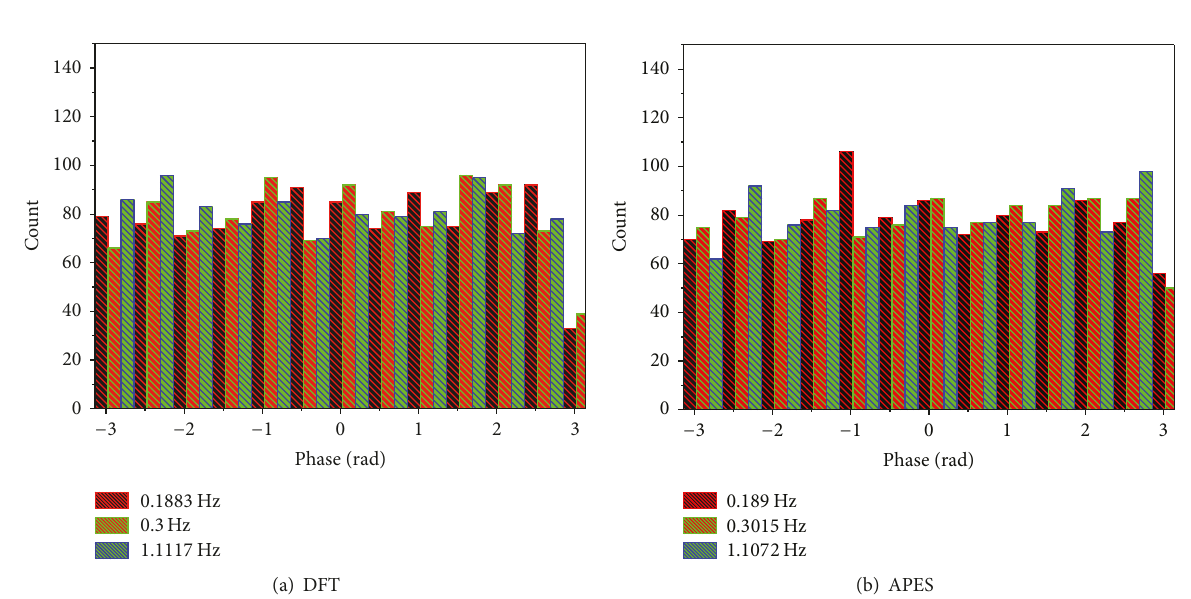
Figure 9: Phase histogram obtained using the two